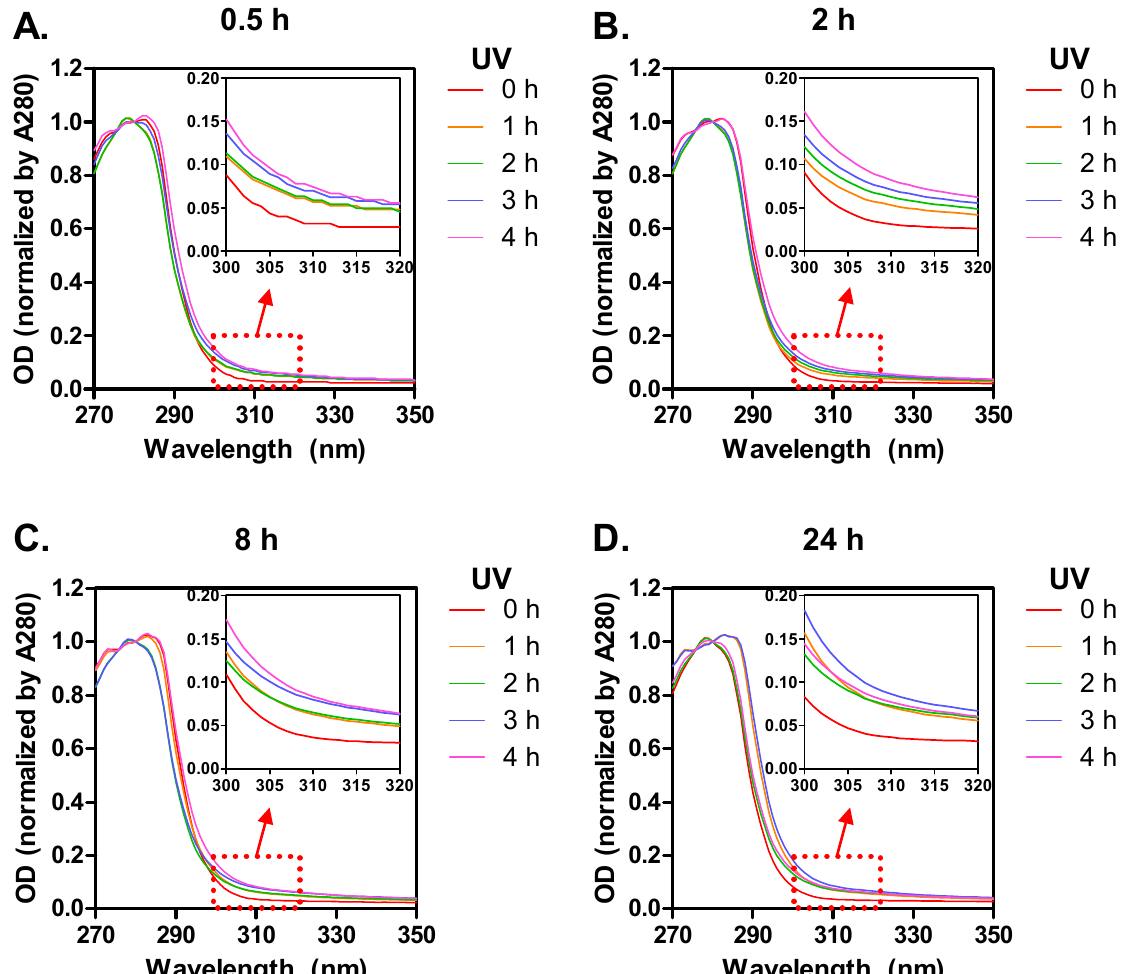
Figure 3. Absorbance spectra of UV-irradiated SF films (1–4 h) prepared with four SF solutions that were dissolved for different times ( A : 0.5 h; B : 2 h; C : 8 h; D : 24 h).